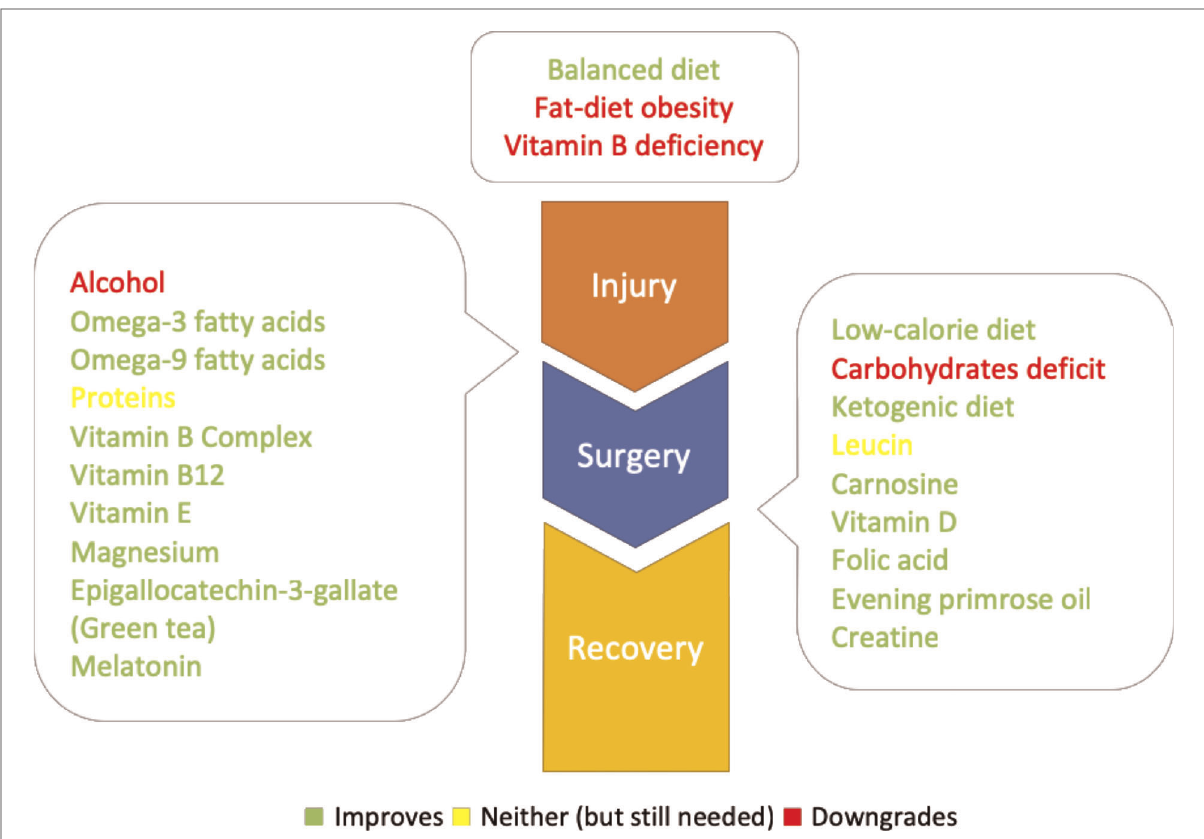
FIGURE 1 Diet, nutrients and supplements with their respective target points: up: predisposing factors; left: predominately neuroprotective (could be taken from the injury onset); right: predominately neuroregenerative (could be taken after the